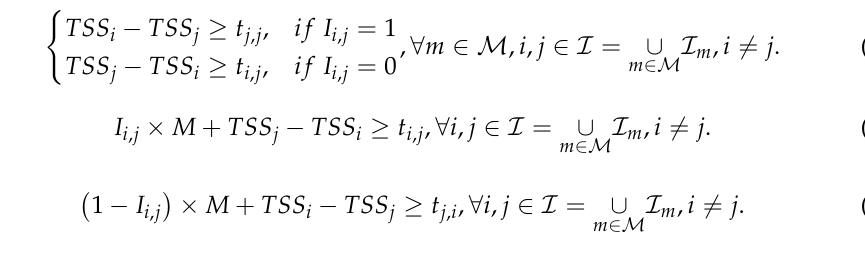
formed as Formulas (31)–(32) by introducing 0 − 1 variables I i , j